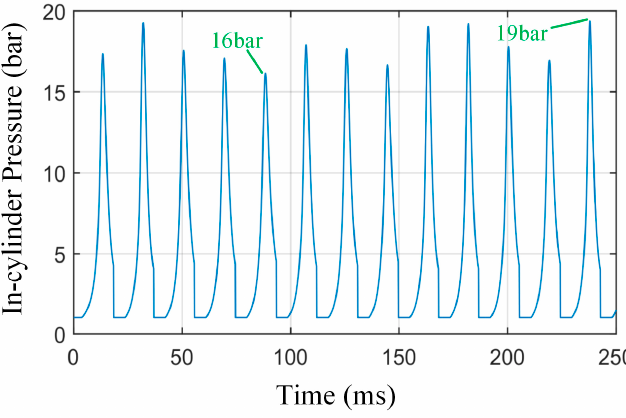
Figure 16. The in-cylinder pressure during 0.25 s.